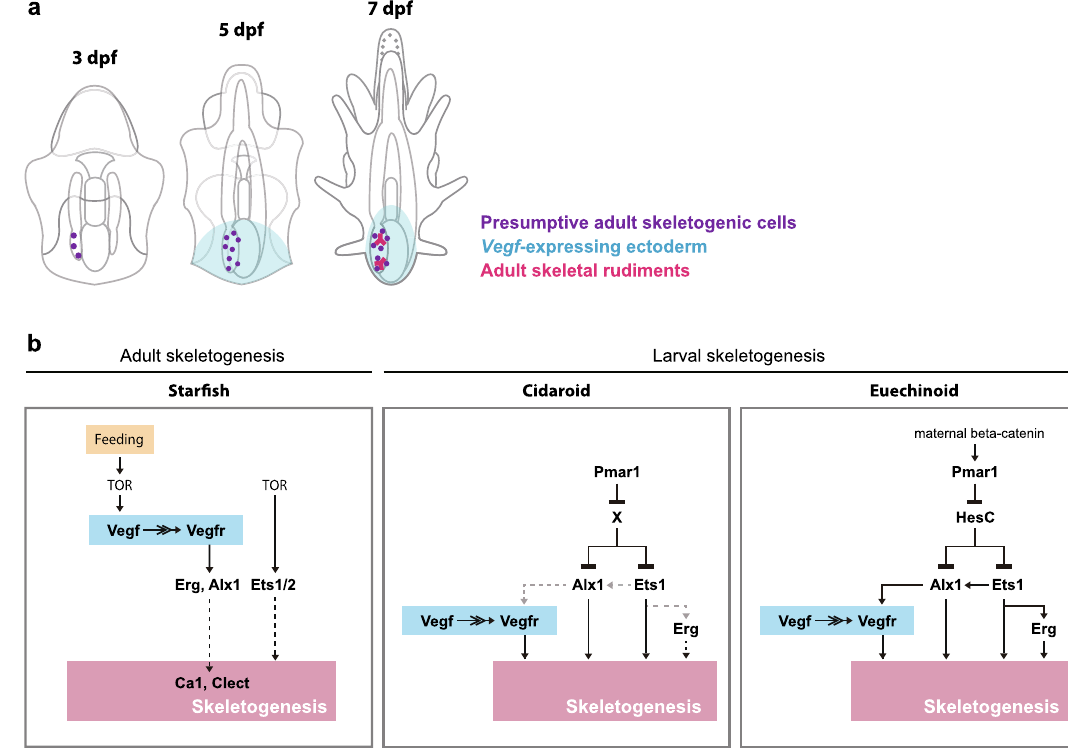
Figure 8. Illustration of skeletogenesis-related regions in starfish larvae ( a ) and comparison of gene regulatory network (GRN) models ( b ). ( a ) Our data suggest that adult skeletogenic cells are derived from cells included in the posterior coelom, and Vegf ligand emitted from the posterior ectoderm binds and activates the receptor Vegfr in dorsal mesenchyme cell lineage, which leads to the formation of adult skeletal rudiments on the dorsal left side of starfish larvae. ( b ) GRN models for adult skeletogenesis in starfish (left) or larval skeletogenesis in cidaroids (center) and euechinoids (right). The regulatory relationships shown by dotted lines were indicated by gene expression analyses. The cidaroid and euechinoid models are based on previous studies 27,29,45,46